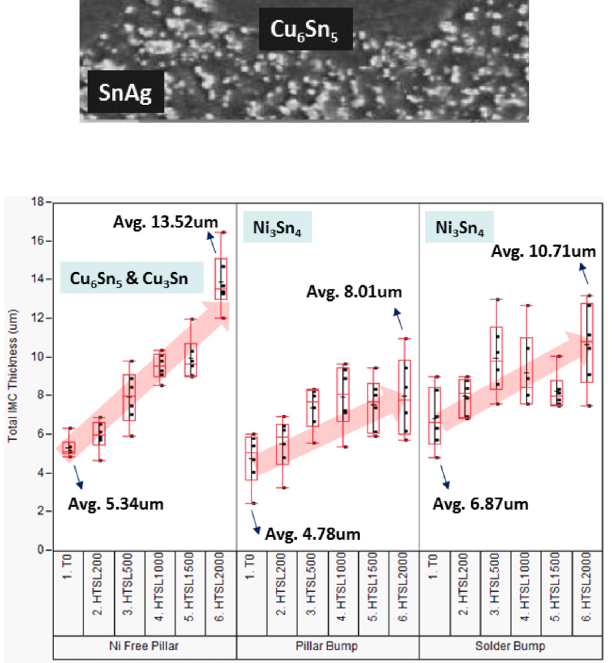
Figure 12. IMC growing